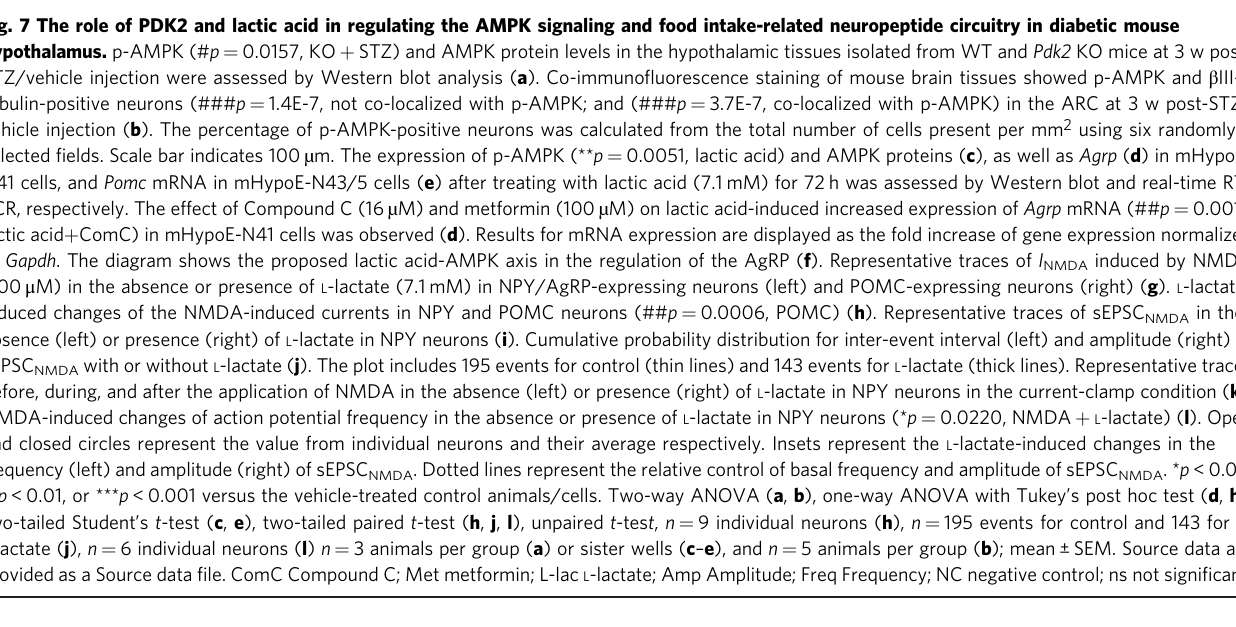
two-tailed Student ’ s t -test ( c , e ), two-tailed paired t -test ( h , j , l ), unpaired t -tes t , n = 9 individual neurons ( h ), n = 195 events for control and 143 for provided as a Source data fi le. ComC Compound C; Met metformin; L-lac L -lactate; Amp Amplitude; Freq Frequency; NC negative control; ns not signi fi